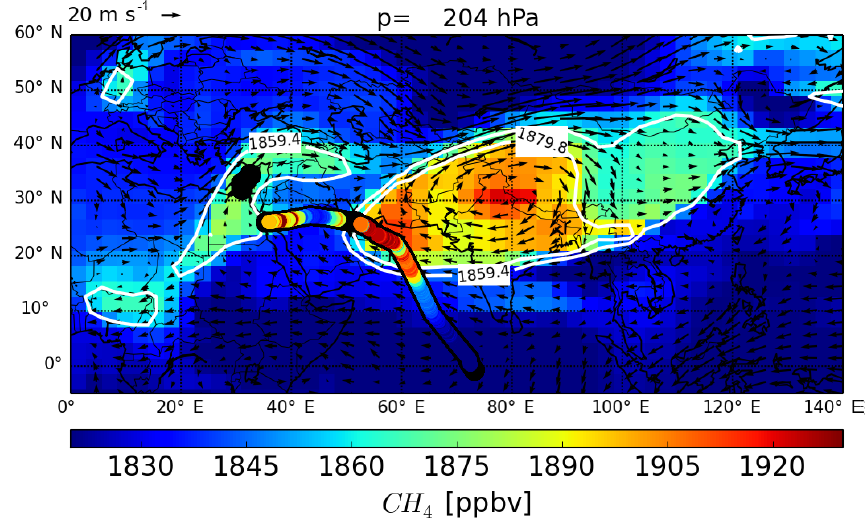
Figure 21. EMAC calculated CH 4 and wind field; daily means at 204hPa, and in situ measured CH 4 (above 300hPa) along the aircraft track for flight 17/18 (10 August 2015). White contours represent the CH 4 threshold and background values according to Sect. 3.1. The enhanced CH 4 values over the Red Sea represent the